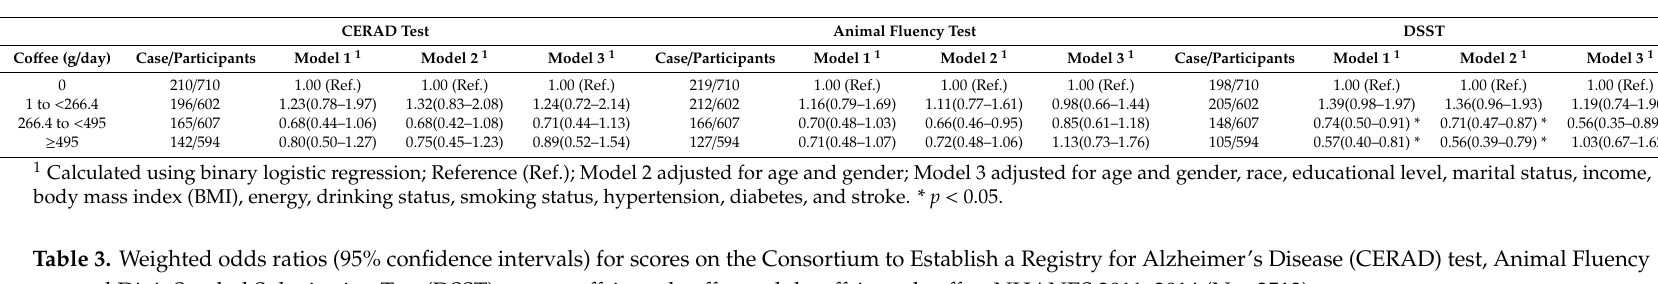
Table 2. Weighted odds ratios (95% confidence intervals) for scores on the Consortium to Establish a Registry for Alzheimer’s Disease (CERAD) test, Animal Fluency